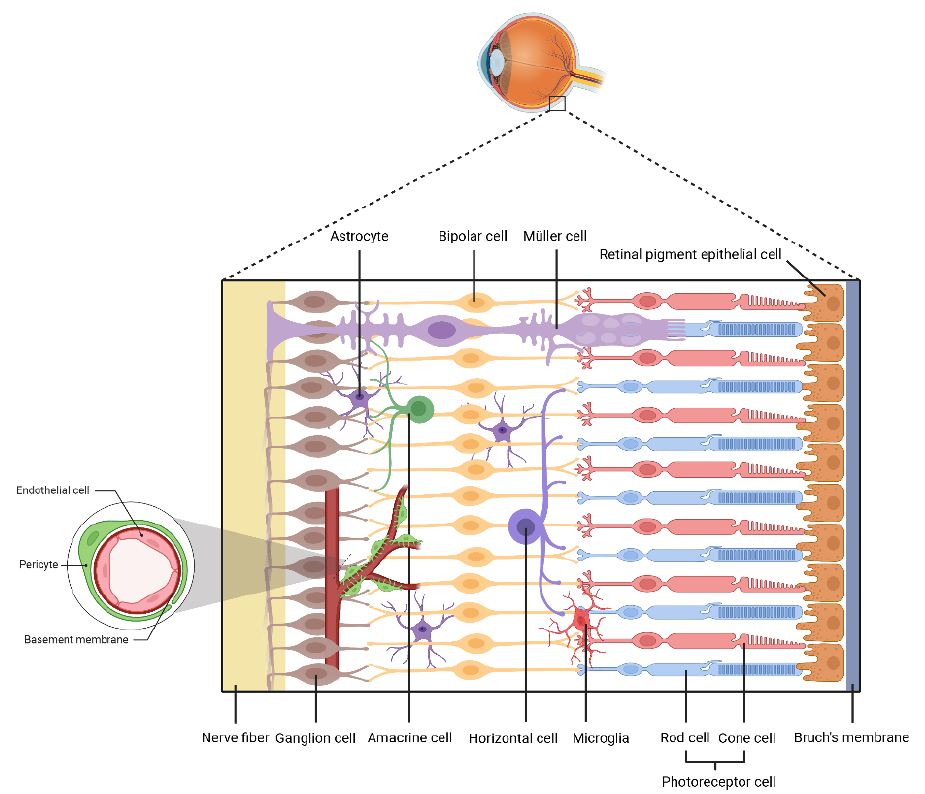
Figure 1. Primary structures in the retina. The retina comprises 55 different cell types, including pigment epithelium cell, photoreceptor cells, bipolar cells, ganglion cells, horizontal cells, amacrine cells, Müller cells, microglia, and astrocytes.